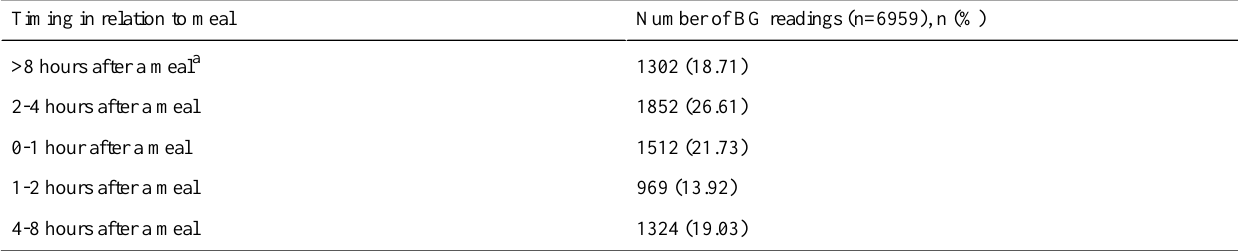
Table 3. Timing of self-monitoring of BG levels.